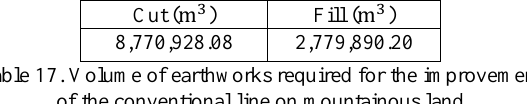
Table 17. Volume of earthworks required for the improvement of the conventional line on mountainous land